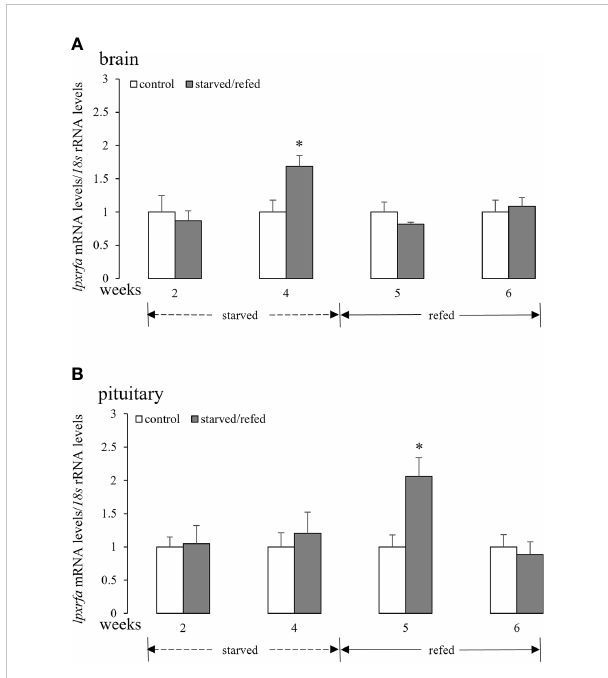
FIGURE 1 Effects of nutritional status on the brain (A) and pituitary (B) lpxrfa mRNA levels in half-smooth tongue sole. Data were normalized against 18s transcripts and are presented as mean ± SEM (n = 4). A star indicates signi fi cant difference between fed and starved/refed groups ( p <